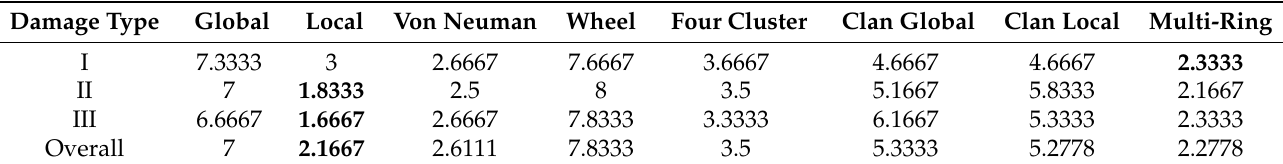
Table 5. Average rank of success rate for each damage type among PSO topologies.